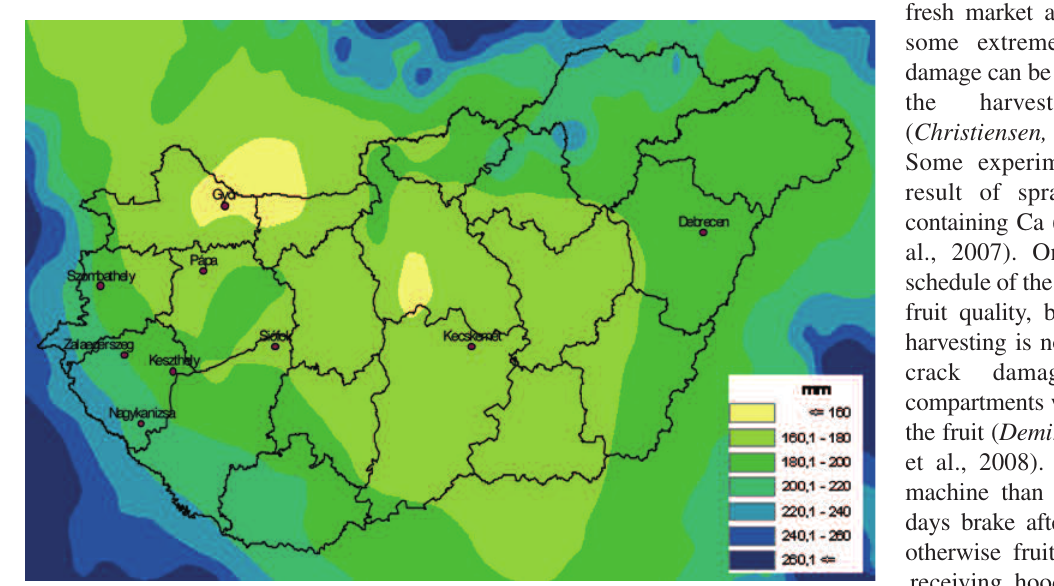
Figure 2. Precipitation during April – June, 1961–1990 (source: CRU database)